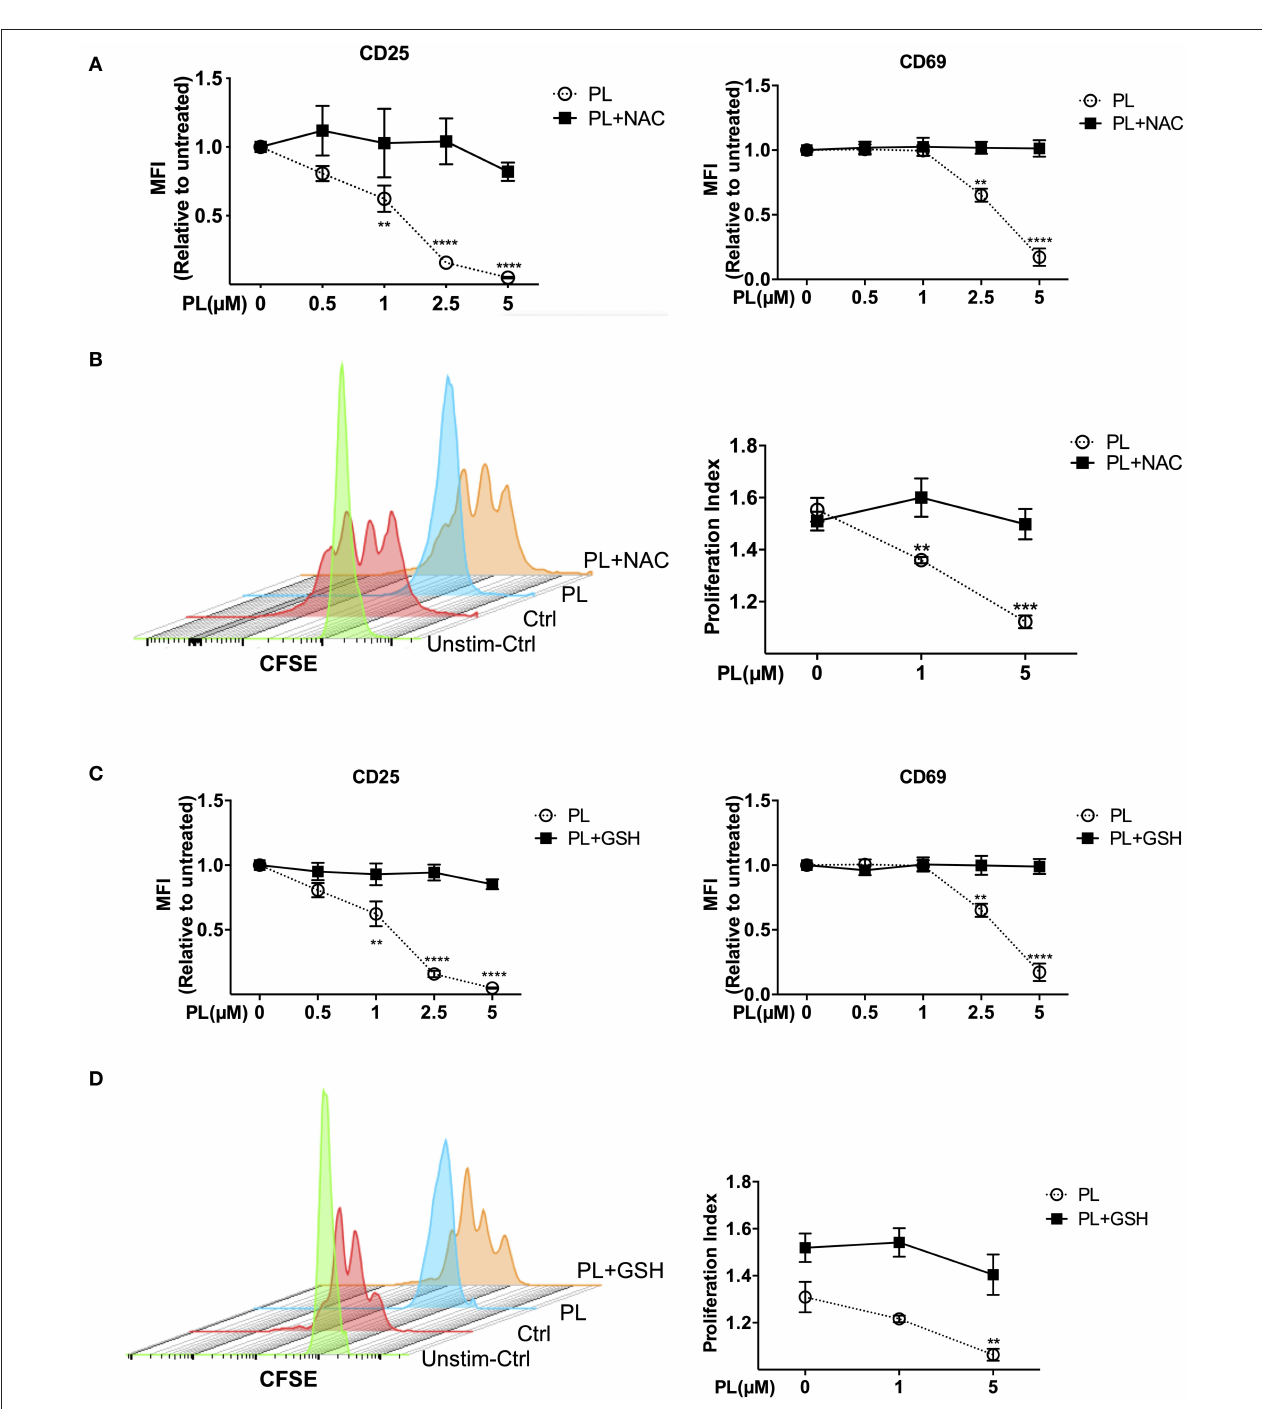
FIGURE 4 | Immunosuppressive effects of PL were abrogated by thiol-containing antioxidants. (A,C) Expression of CD25 (left) and CD69 (right) in T cells was analyzed by flow cytometry. T cells in the presence/absence of PL and (A) NAC or (C) GSH were costimulated with anti-CD3/CD28 antibodies for 24h. Shown are the MFI ratios of PL-treated to untreated samples. (B,D) T cell proliferation was detected via staining of CFSE. T cells were loaded with CFSE, thereafter costimulated with anti-CD3/CD28 antibodies in the absence/presence of PL without or with addition of exogenous (B) NAC or (D) GSH. CFSE signal was measured after 72h of costimulation by flow cytometry. Shown are representative histograms (left) and the proliferation index (right) ( n = 3; mean; SEM; ** p < 0.01, *** p < 0.001, **** p < 0.0001).